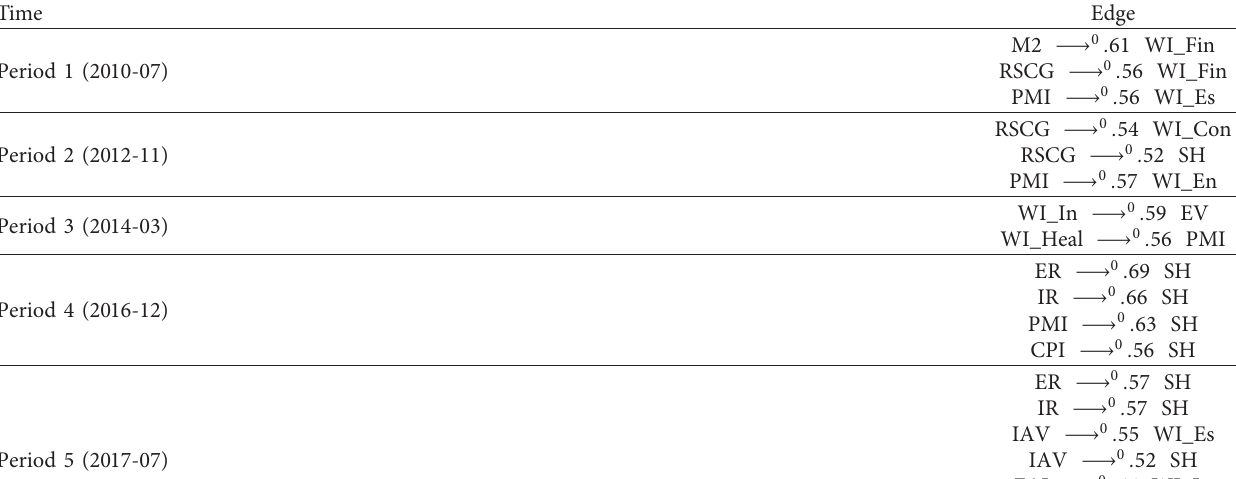
Table 4: The posterior probabilities for linking edges in Figure